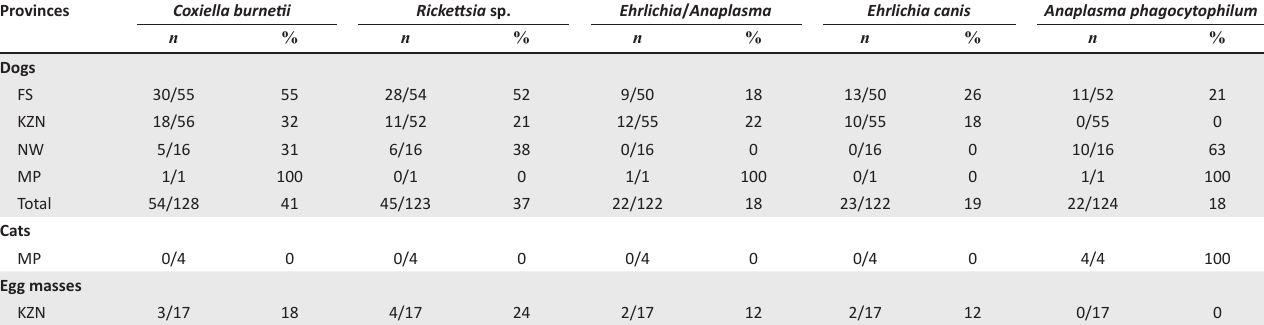
TABLE 2: Overall infection rates of ticks with target pathogens per province. Provinces Coxiella